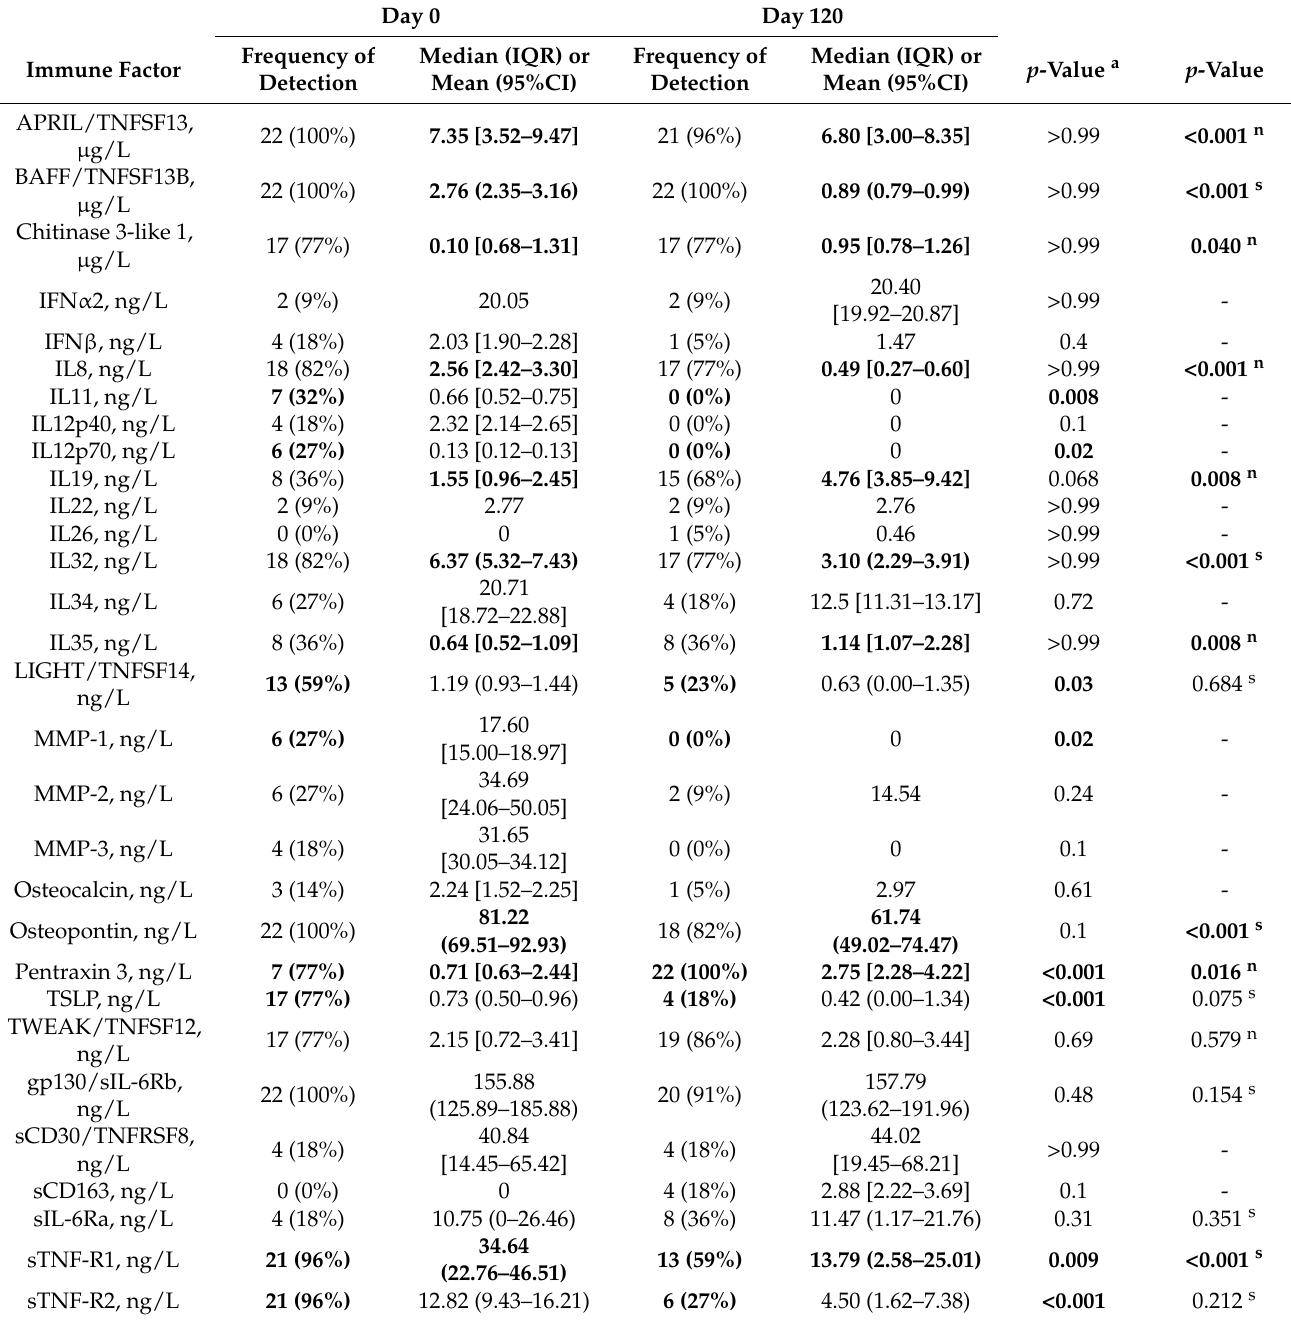
Table 3. Frequency of detection (%) and concentration of immune factors in nasal samples from the recruited participants before (day 0) and at the end (day 120) of the